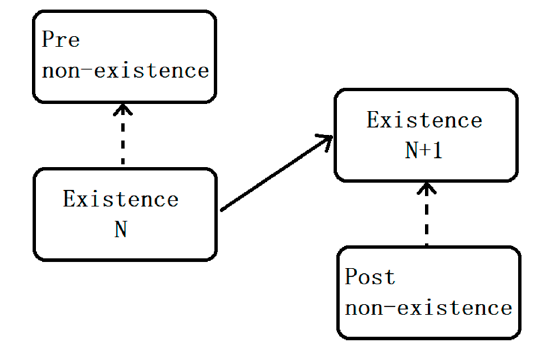
Figure 2. Transformation between Existence and Nonexistence